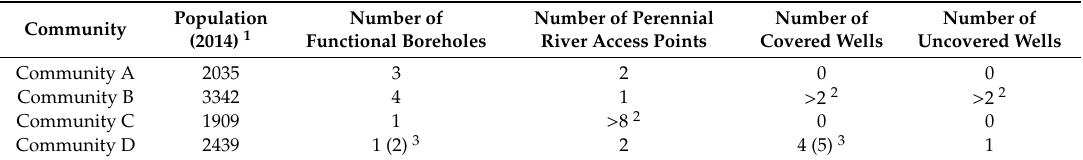
Table A1. Study Community Characteristics.